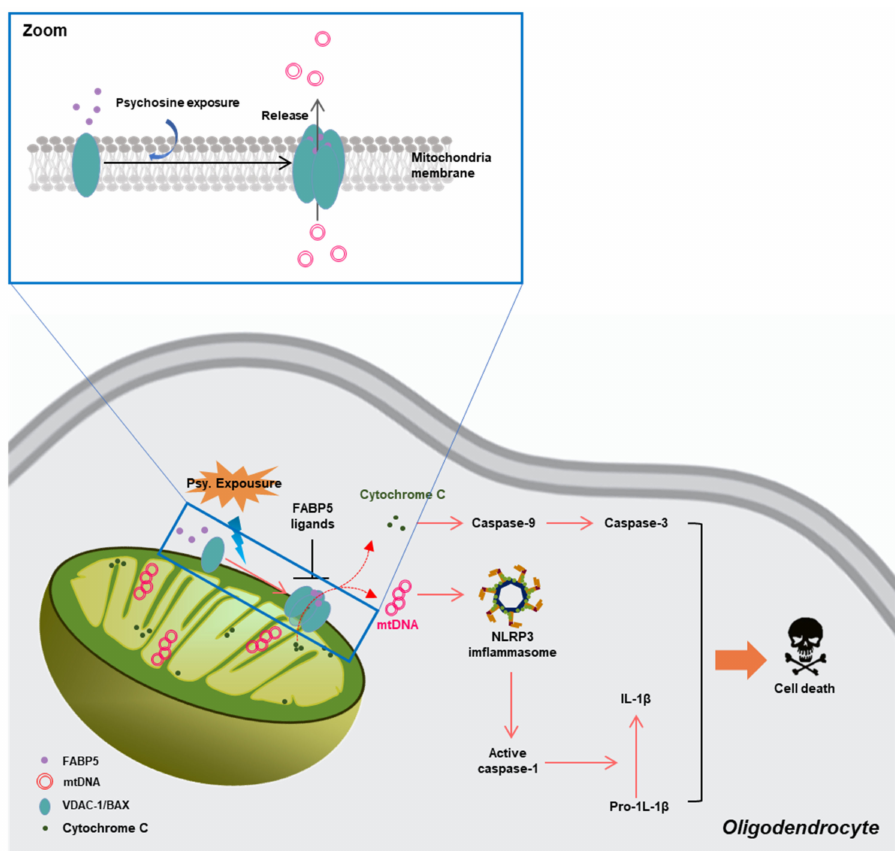
Figure 4. Schematic representation of the pathways through which FABP5 facilitates mitochondrial macropore formation and induces oligodendrocyte apoptosis [18]. FABP—fatty acid-binding